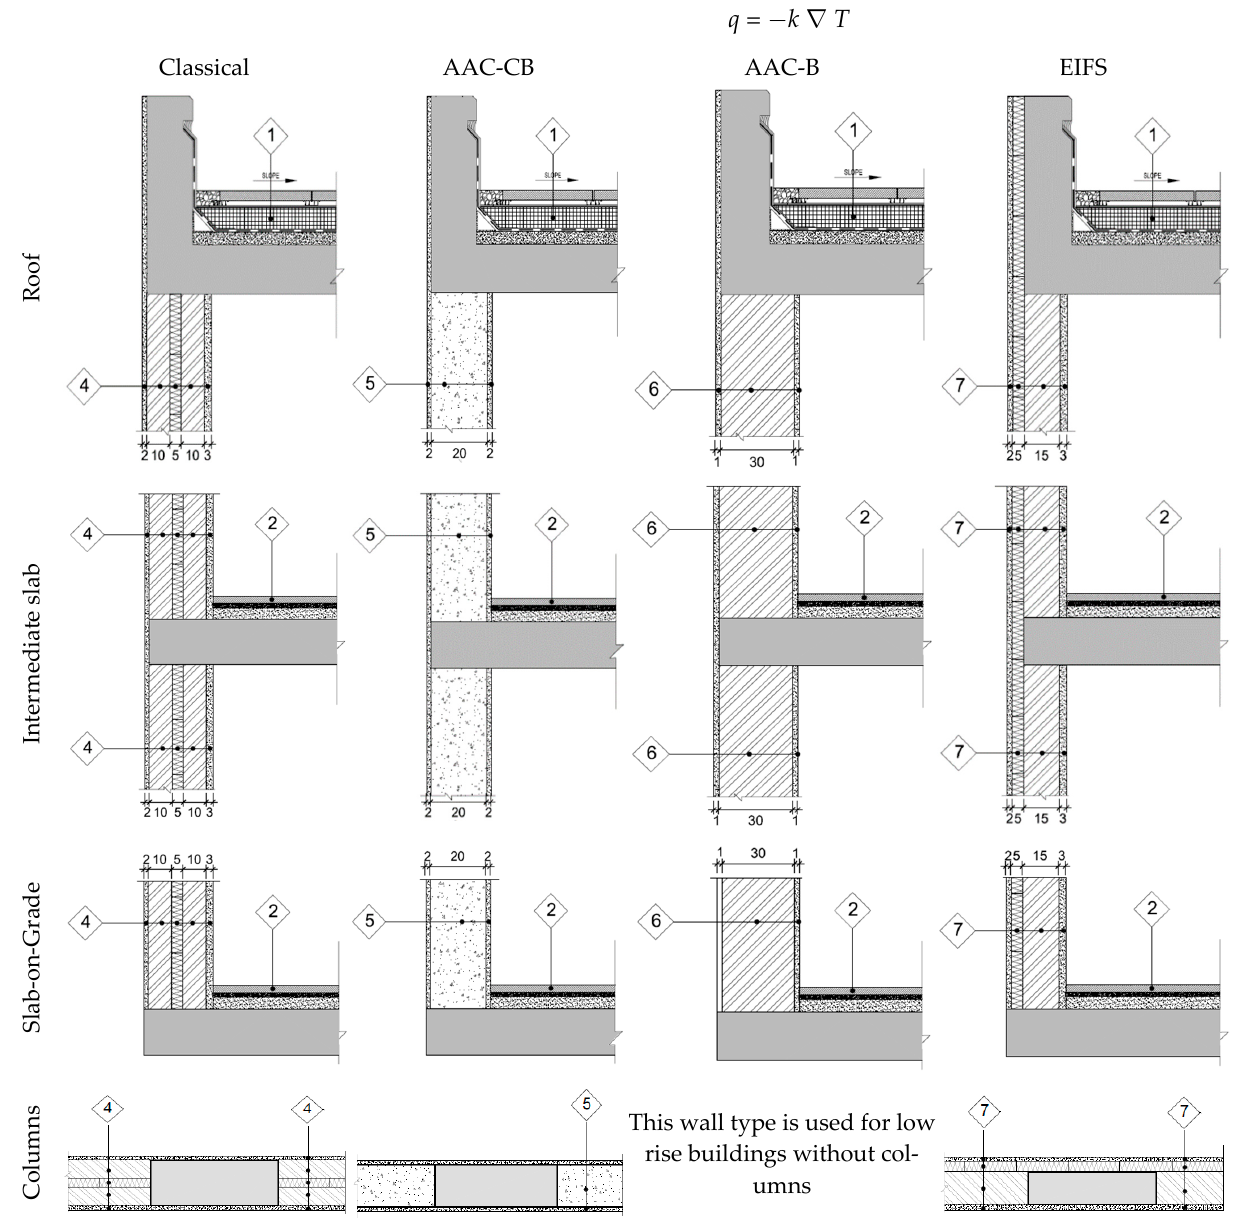
Figure 2. The considered four thermal bridge junctions (roof, intermediate slab, slab-on-grade, and concrete columns) for the tested four wall types. 1. Roof slab; 2a. Slab-on-Grade; 2b. Intermediate Floor slab; 4. Classical; 5. AAC Colm. Beam (AAC-CB); 6. AAC-Block (AAC-B); 7. Exterior Insulation and Finish System (EIFS).